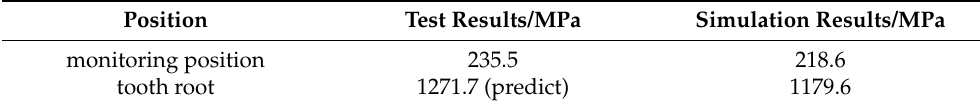
Table 13. Comparison of stress simulation and test results.